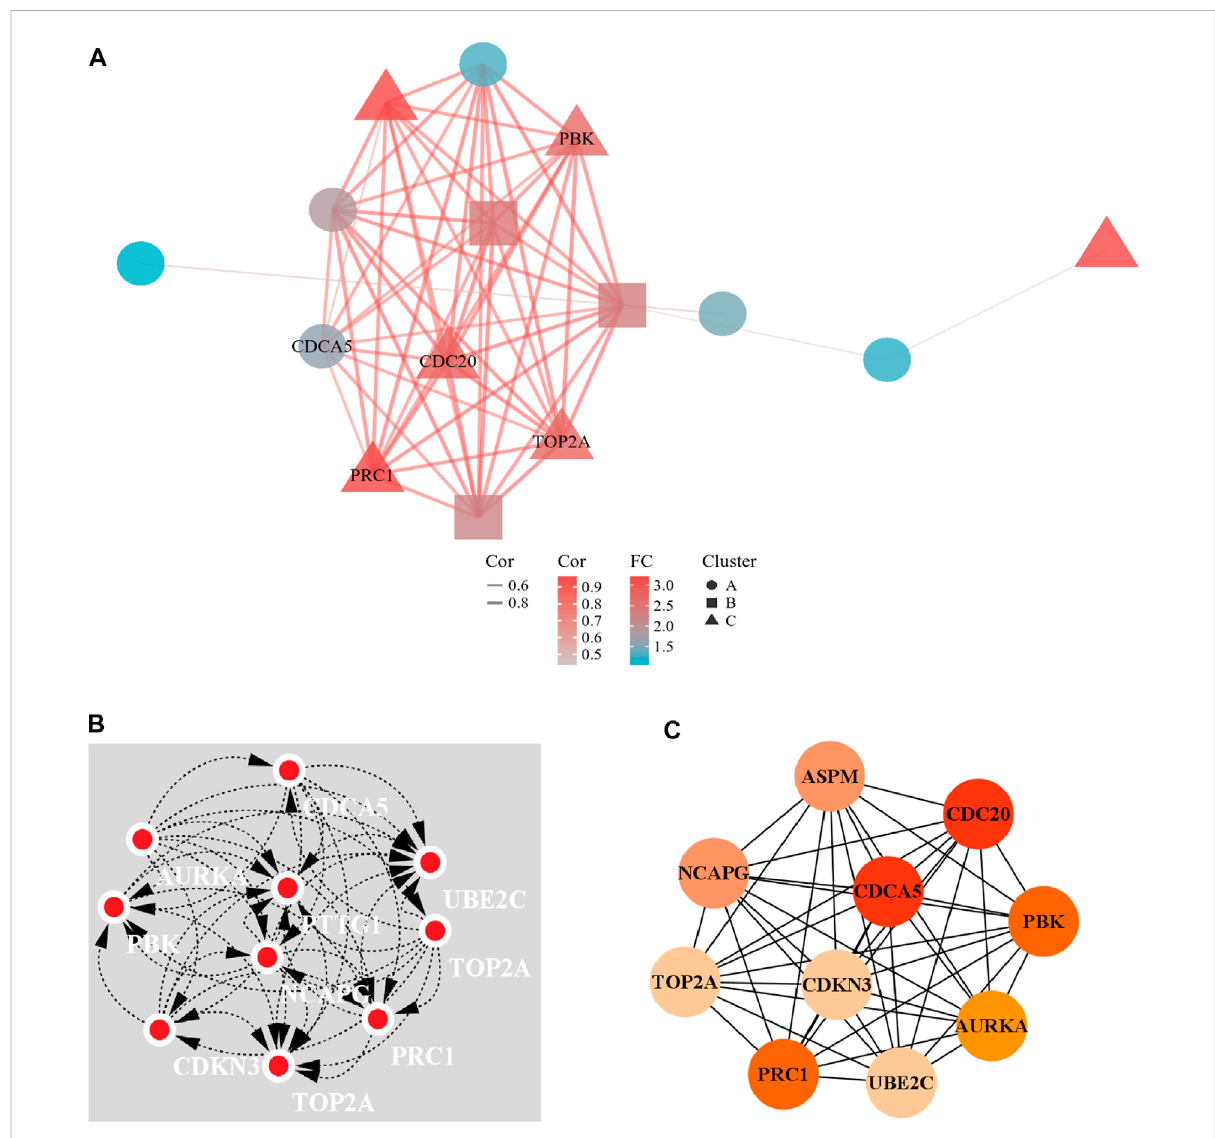
FIGURE 3 The PPI network of up-regulated DEGs and the interaction network of top 10 hub genes. (A) The PPI network of the 23 up-regulated DEGs. (B) Top 10 hub gene network constructed by clustering topological method. (C) Top 10 hub gene network constructed by EPC topological